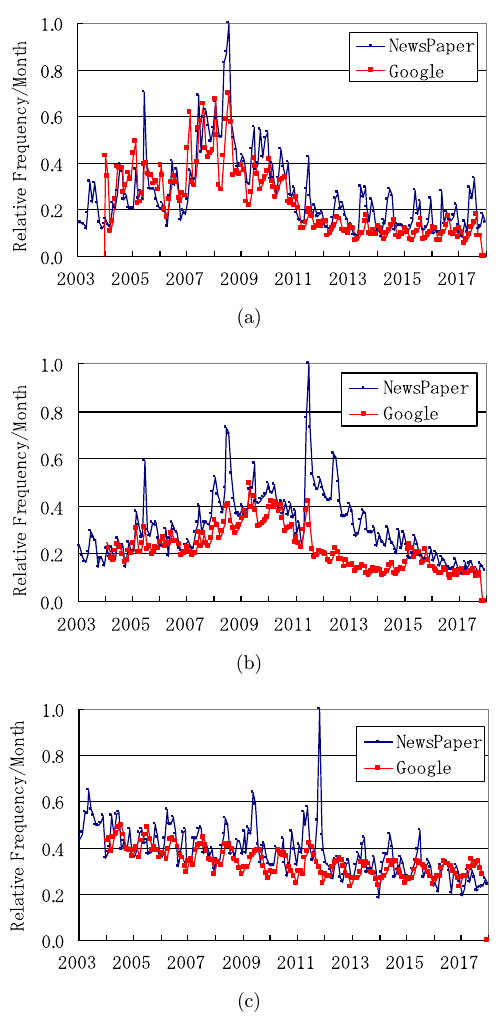
Fig. 3. Frequency distribution of Internet retrieval search using Google Insights (given by red lines) for (a) the global warming, (b) the energy saving and (c) nature. The maximum frequency of each search after the year 2004 is conveniently normalized to 0.5 for the comparison to the newspaper values (given by black